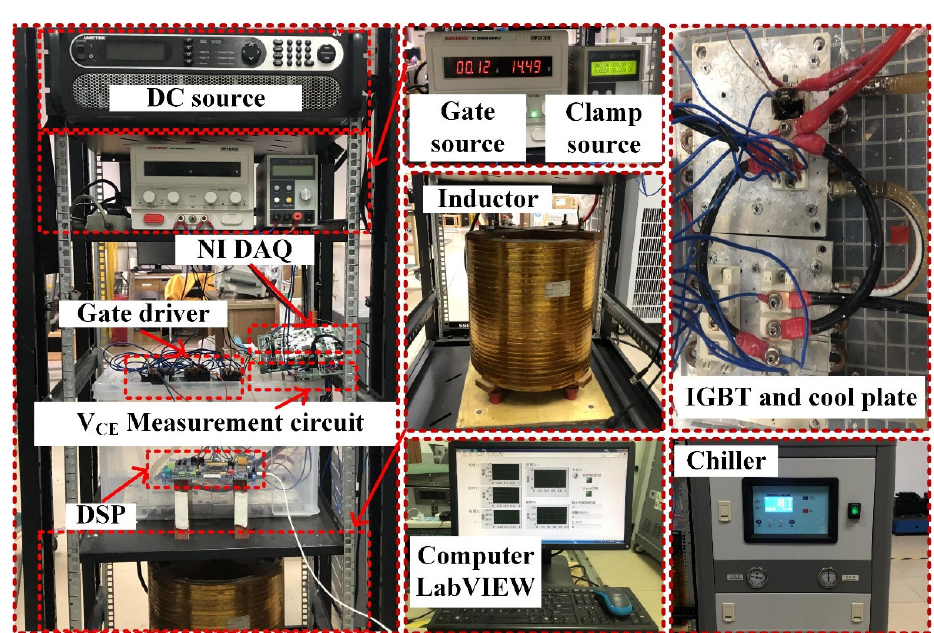
Figure 16. Test bench.